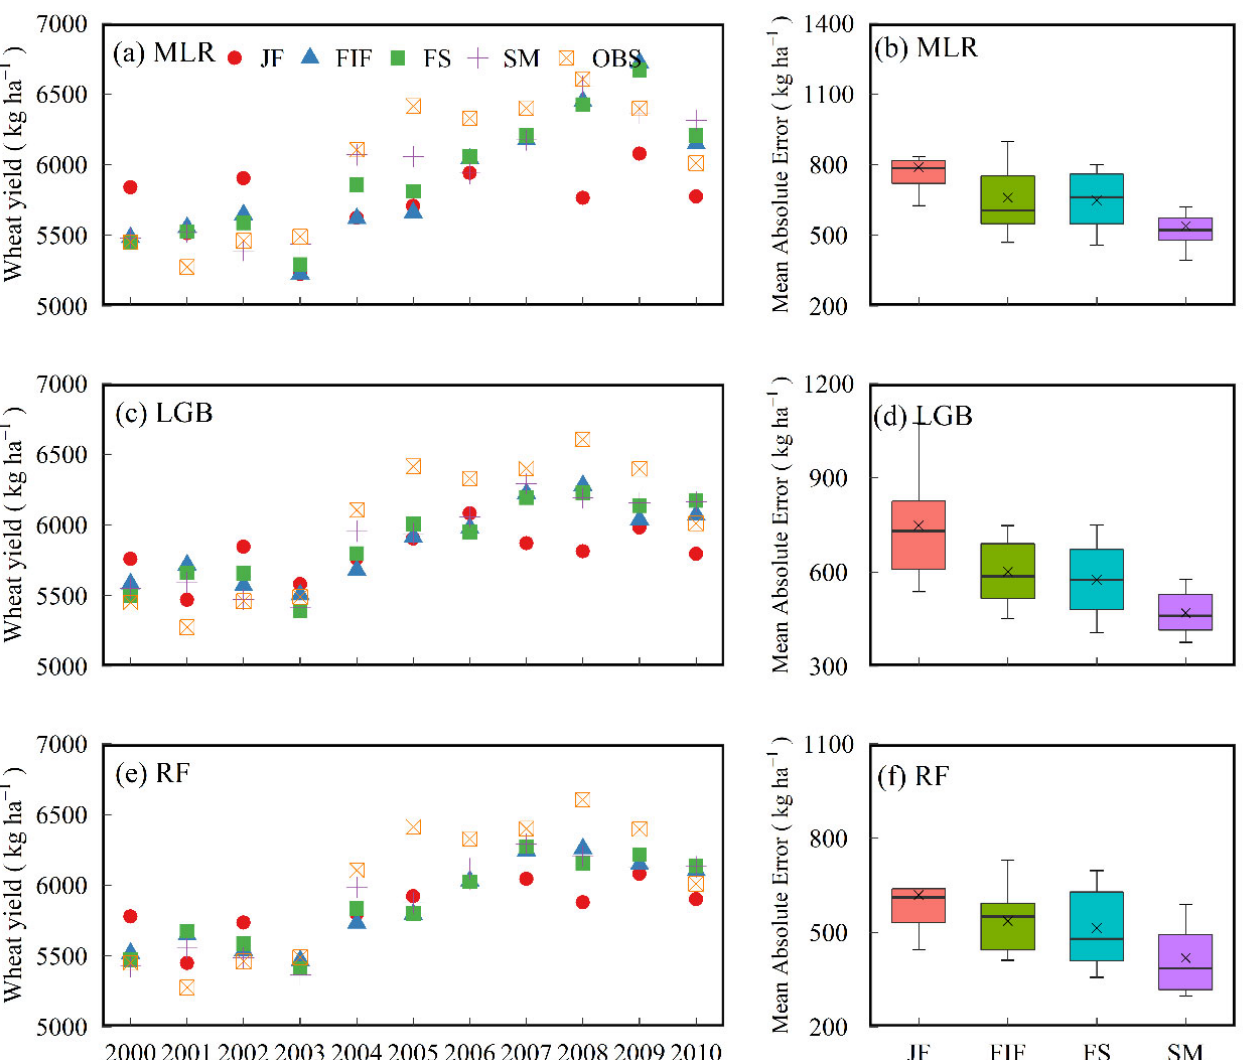
Figure 6. Time series of observed and predicted wheat yields across the investigated sites under irrigated conditions based on the four prediction events from multiple linear regression (MLR) ( a , b ), light gradient boosting machine (LGB) ( c , d ), and random forest (RF) ( e , f ). Wheat yields for each year were averaged across the investigated sites under irrigated conditions. Data were generated from the “leave-one-year-out” cross-validation procedure from the three regression models. JF, FIF, FS, and SM were the periods from the end of the juvenile stage to floral initiation, from floral initiation to flowering, from flowering to the start of grain filling, and from the start of grain filling to the milky stage, respectively.